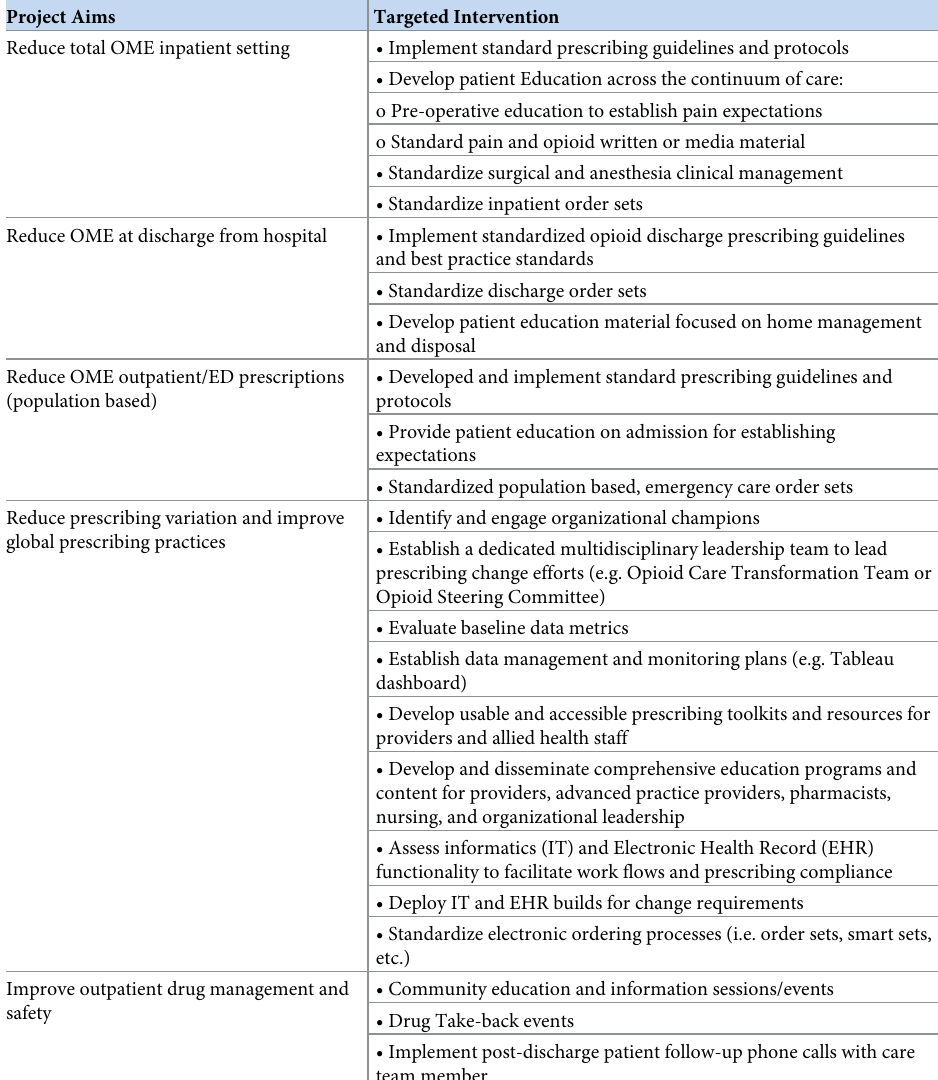
Table 3. Quality improvement